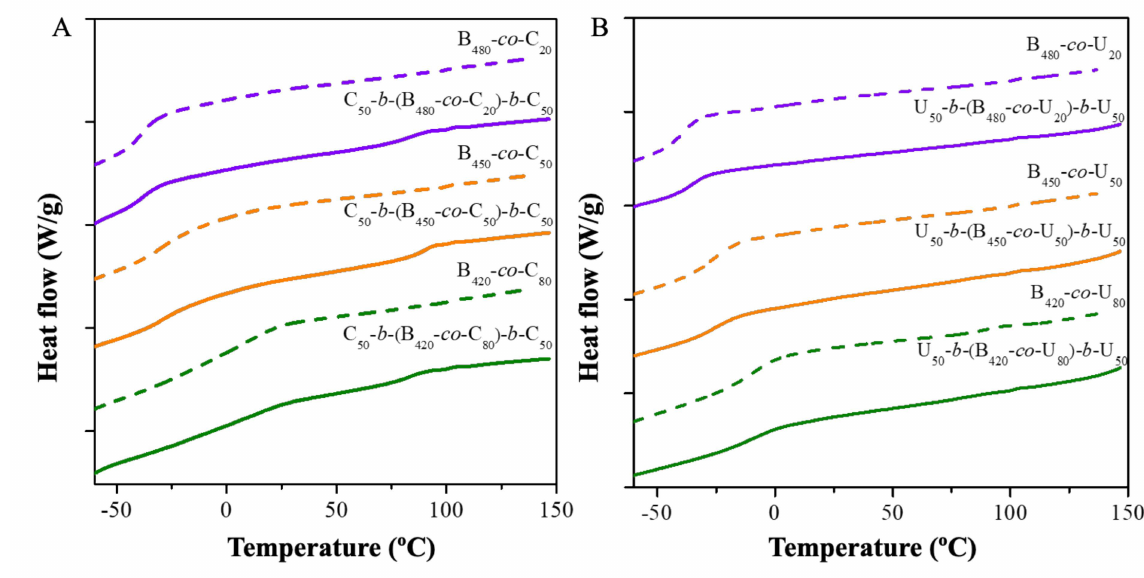
Figure 3. DSC thermograms of ( A ) CyA and ( B ) UCyA triblock copolymers with varied amounts of hydrogen bonding